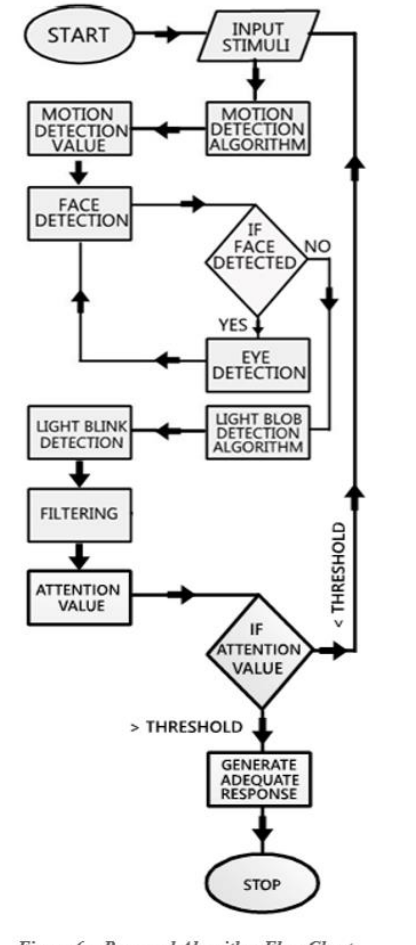
algorithm will process the data through Light blob Algorithm. The image frames will pass through